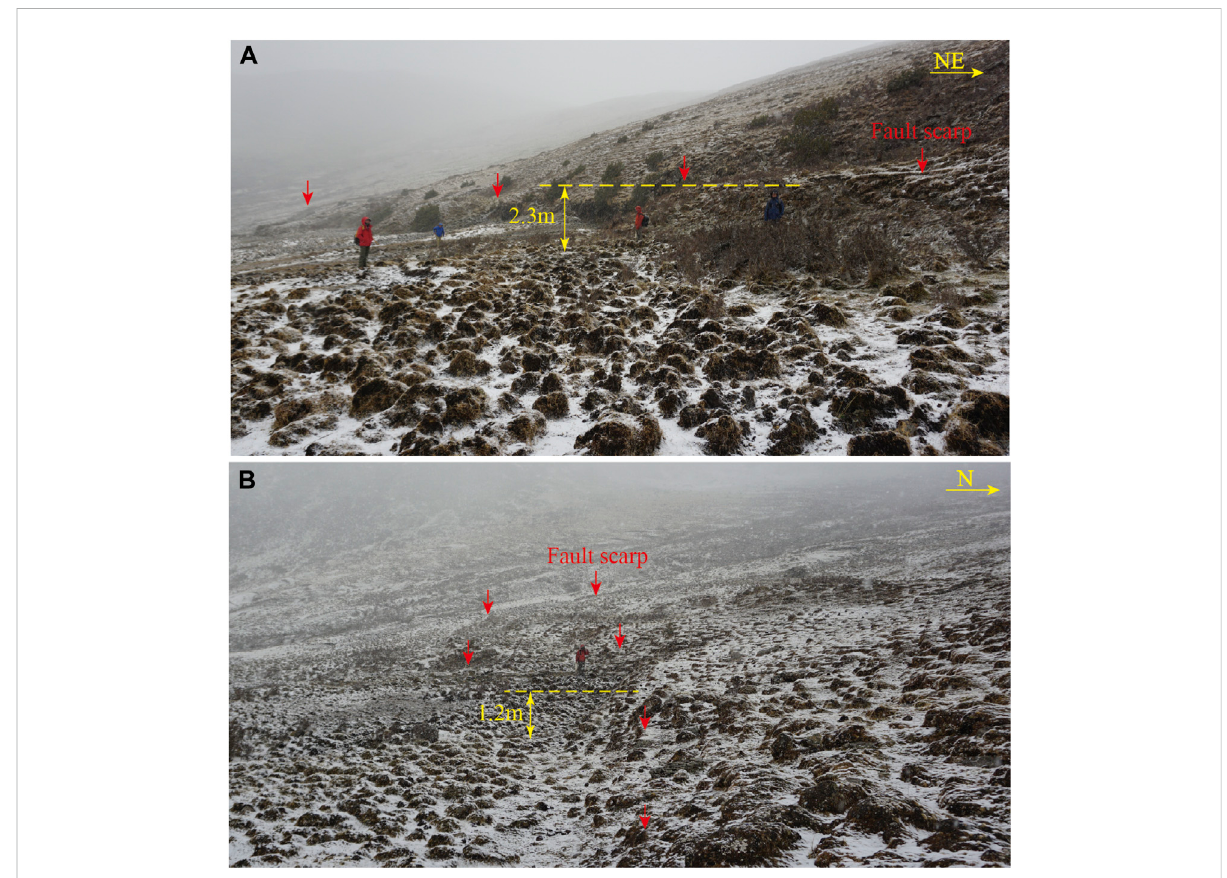
FIGURE 7 Track of theseismic surface rupture near Sedi, close to Babang. (A) Linear fault scarp and seismic scarp (E98.78100 ° , N31.67214 ° ), and (B) partial segment rupture zone where the zone diverges into multiple branches (E98.77832 ° , N31.67261 °